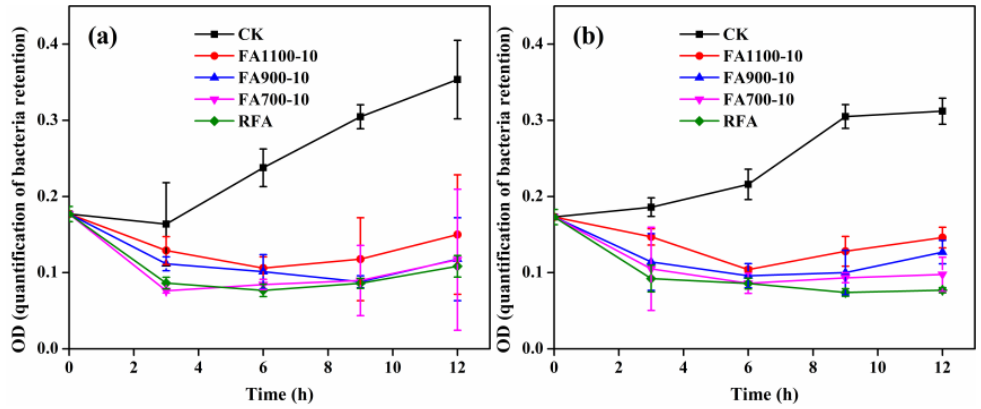
Figure 6. Time-killing curves of RFA, FA700-10, FA900-10, and FA1100-10 against ( a ) E. coli and ( b ) S. aureus.